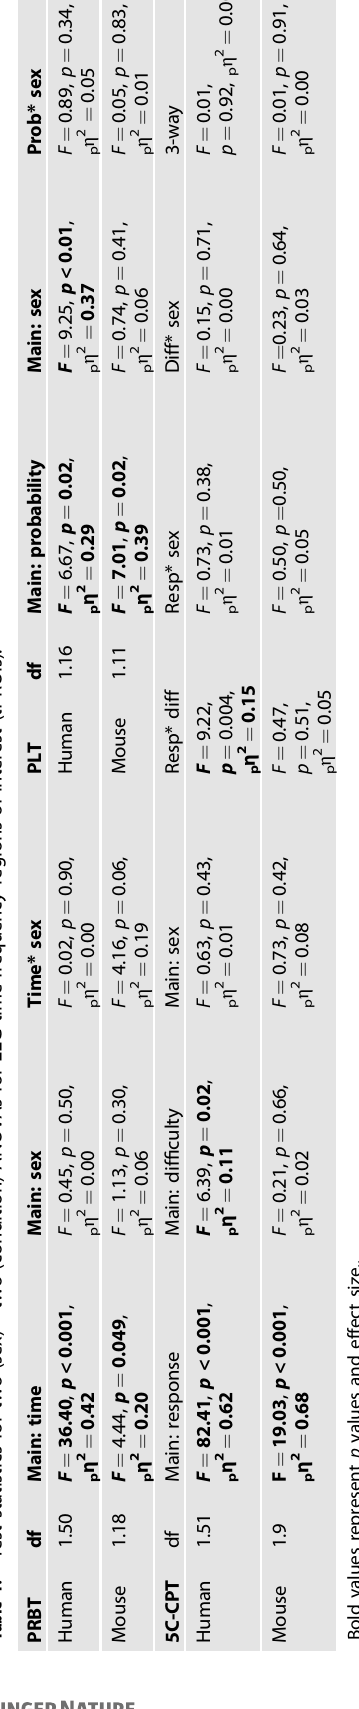
Table 2. Test statistics for 2 (sex) * 2 (condition) ANOVAs for behavioral performance on the PLT and 5